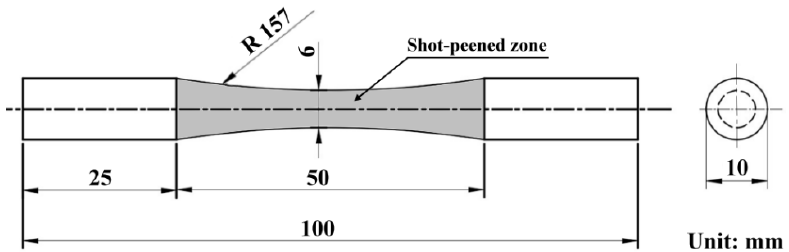
Figure 1. The dimensions of rotating beam fatigue specimen. Surface roughness ( Ra ): substrate 0.178 μ m, shot-peened sample 0.240 μ m.